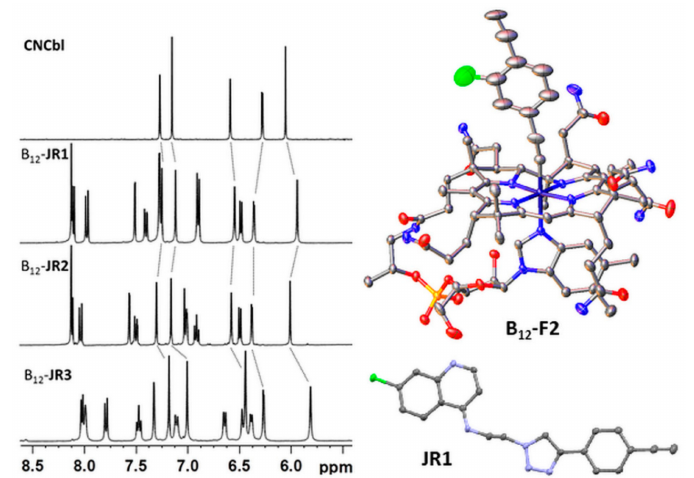
Figure 3. Left, aromatic region of the 1 H-NMR spectra (D 2 O, 500 MHz) of CN-Cbl and of the derivatives B 12 - JR1 to - JR3 . Right, crystal structure of compound B 12 - F2 and of JR1 (thermal ellipsoids are shown at the 50%